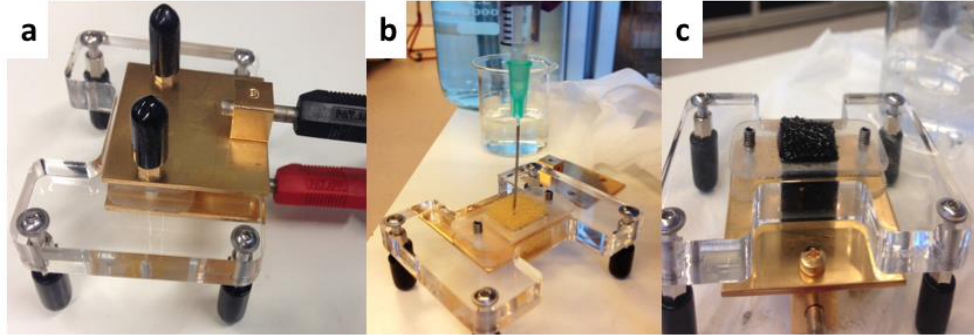
Figure 2. ( a ) Ex situ conductivity device with two electrodes. ( b ) Overview of anolyte media injection to achieve saturated conditions. ( c ) Visual example of saturated conditions for ex situ electrochemical impedance spectrometry (EIS) measurement.